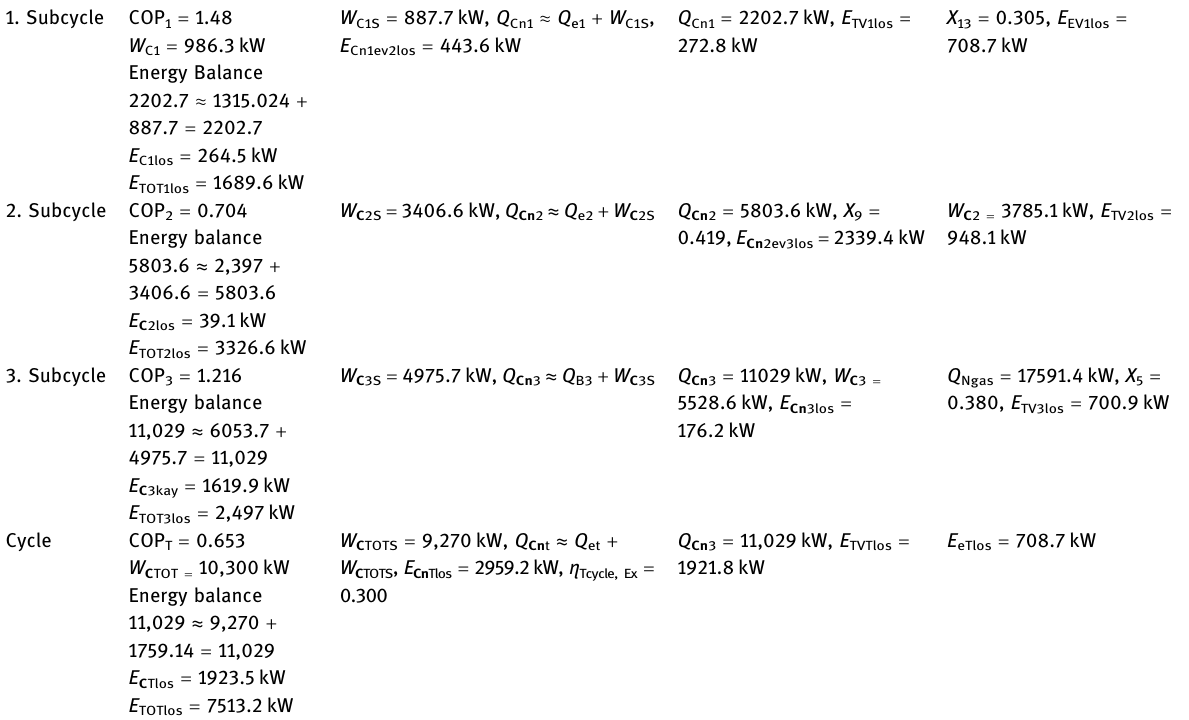
1. Subcycle COP 1 = 1.48